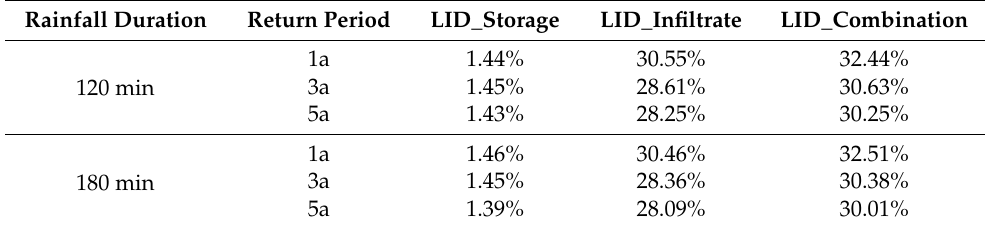
Table 9. Reduction rates of peak flow by various LID types.